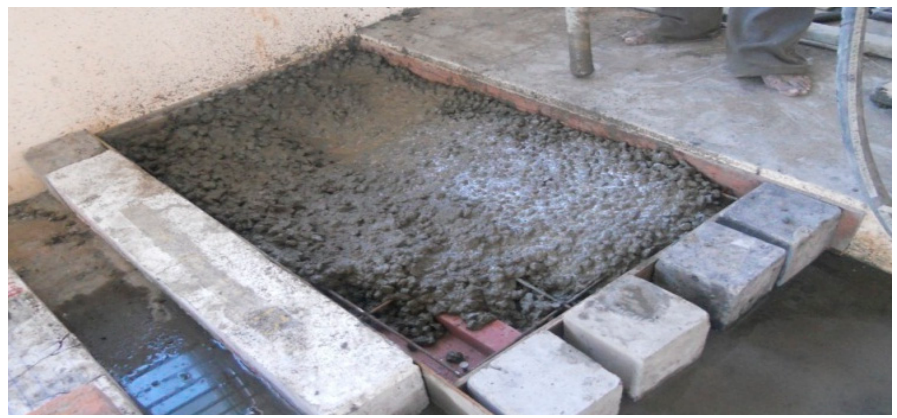
Figure 7. Casting of specimen.